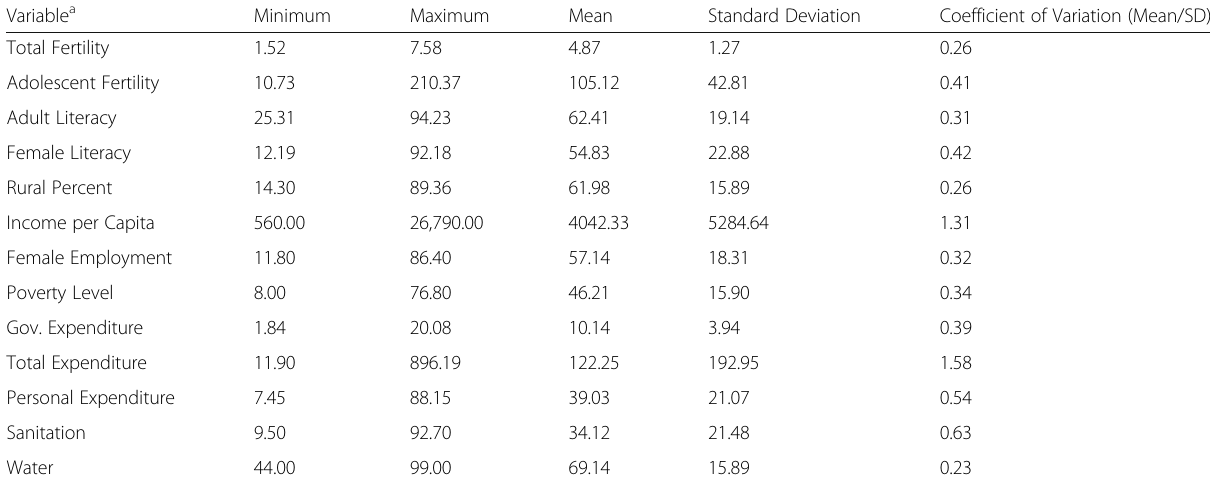
Table 3 Descriptive statistics for independent variables in the study Variable